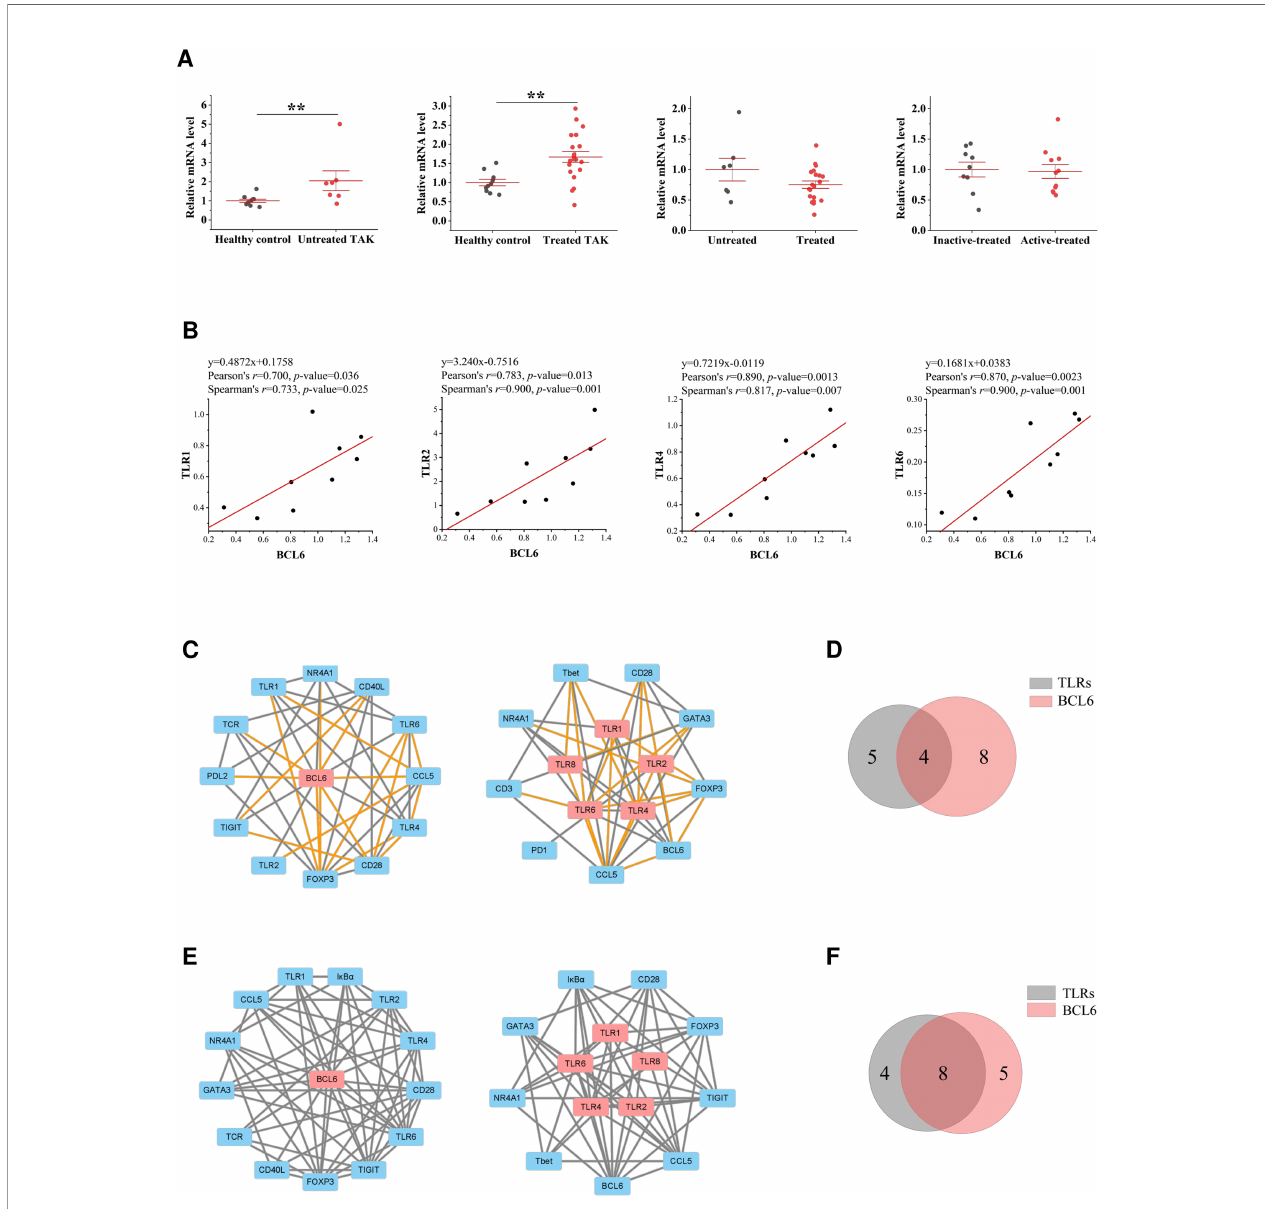
FIGURE 7 | The close functional relationship between BCL6 and Toll-like receptors (TLRs) in inactive-treated TAK. (A) Gene expression differential analysis. Mann – Whitney test. ** p < 0.01. The red center line represented the mean value of the mRNA level, and the error bar showed the standard deviation. (B) The scatter plots and the linear regression of the BCL6-TLR1 pair, the BCL6-TLR2 pair, the BCL6-TLR4 pair, and the BCL6-TLR6 pair in the inactive-treated TAK group, indicating that BCL6 was co-expressed with multiple TLRs. (C)~(F) BCL6 and TLRs shared multiple co-expressed genes. (C) The gene co-expression network consisting of BCL6 (left panel) or TLRs (right panel) and its/their neighborhoods based on Pearson correlation. (D) Intersections of the neighborhood-gene between BCL6 and TLRs based on Pearson correlation. (E) The gene co-expression network consisting of BCL6 (left panel) or TLRs (right panel) and its/their neighborhoods based on Spearman correlation. (F) Intersections of the neighborhood-gene between BCL6 and TLRs based on Spearman correlation. Healthy controls, n=10 people. Untreated TAK, n=7 people. Treated TAK, n=20 people. Active-treated TAK. n=11 people. Inactive-treated TAK, n=9 people. TAK, Takayasu ’ s